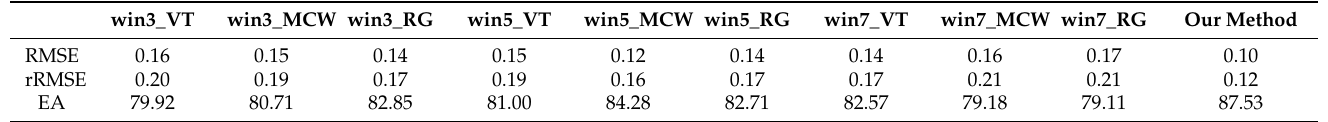
Table 3. FCC-estimation accuracy of white birch forest. Win3_VT refers to adopting 3 × 3 window size to detect treetops and using the Voronoi tessellation algorithm to delineate tree-crown area. Our method refers to the FCC estimation of this study used, which combines the optimal results of treetop detection and tree-crown delineation.